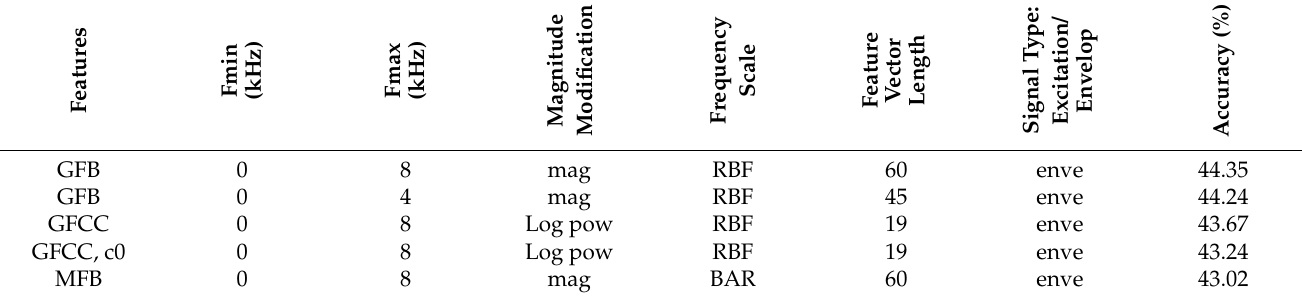
Table 3. The 5 best methods and settings observed on IEMOCAP database sorted in descending order.